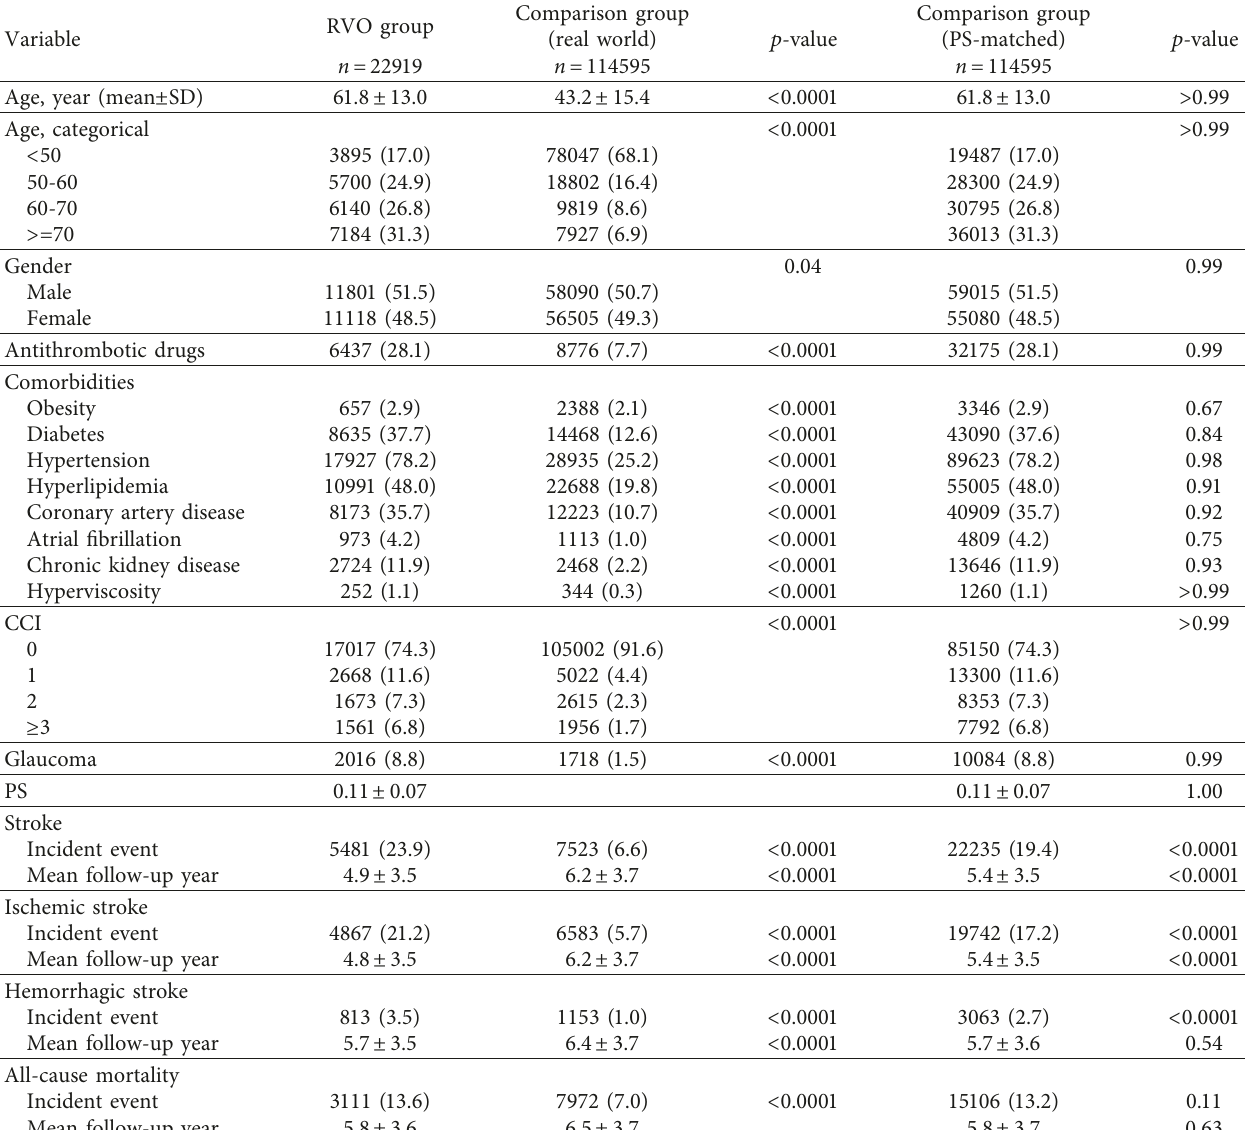
Table 1: Characteristics of the study